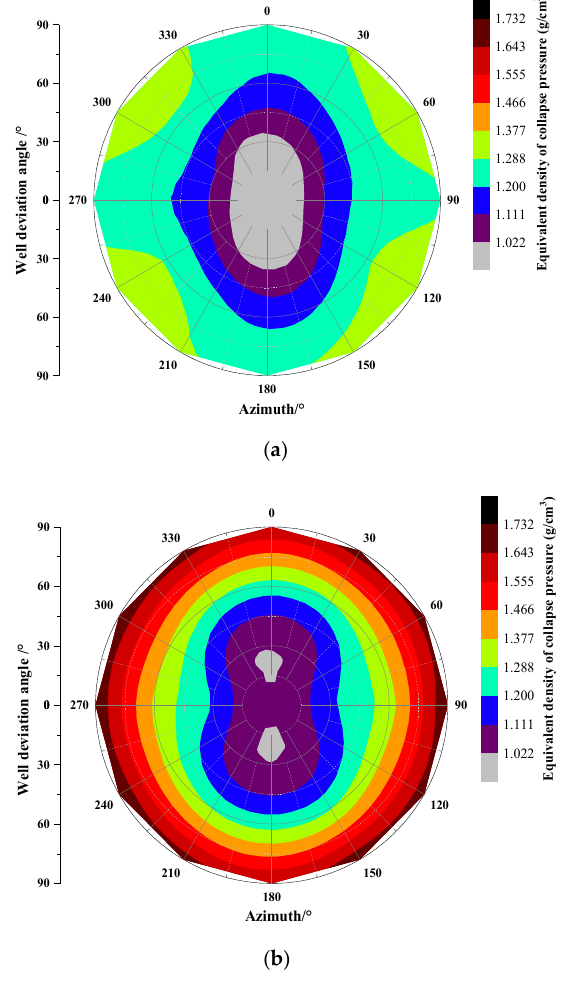
( c ) Figure 12. Collapse pressure distribution under different number of structural planes: ( a ) no struc- tural plane; ( b ) one structural plane; ( c ) three structural